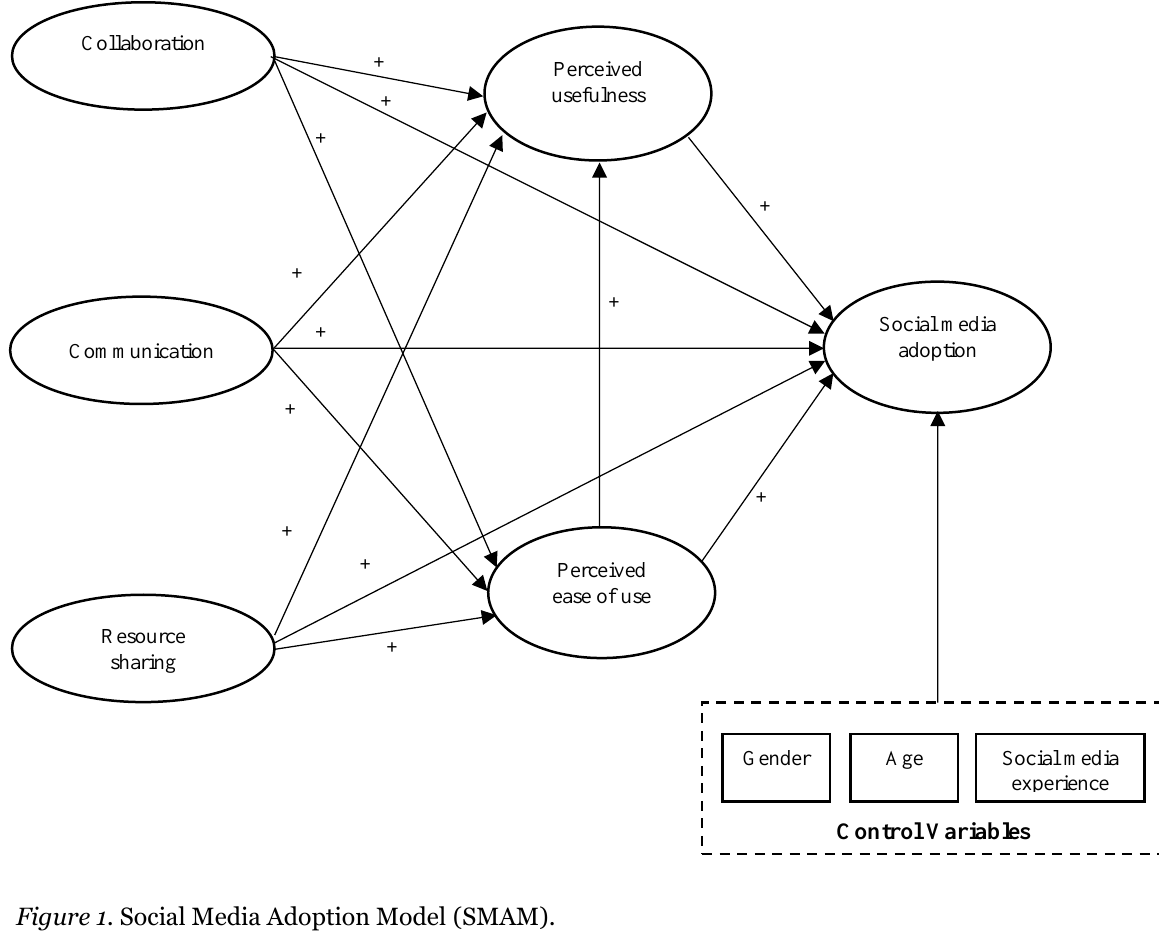
Figure 1. Social Media Adoption Model